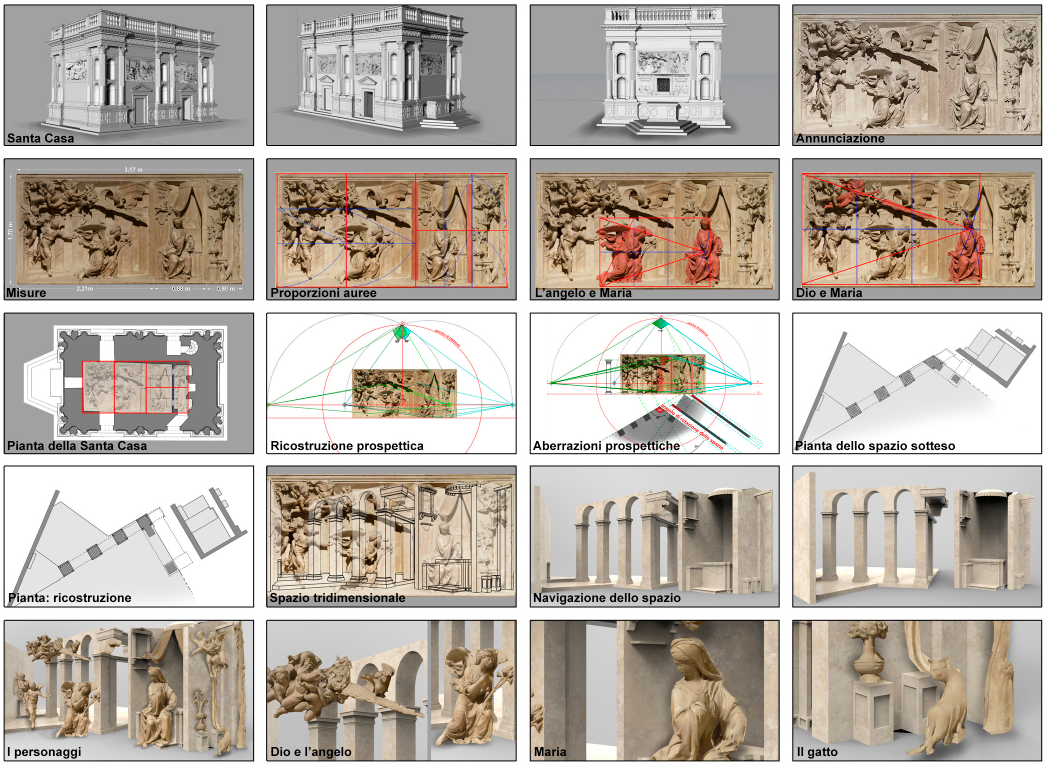
Figure 7. Storyboard. Sequence of images drawn from the visual storytelling that retraces and explains the organization of the analytical process that led to the reconstruction of the scenic space depicted in the